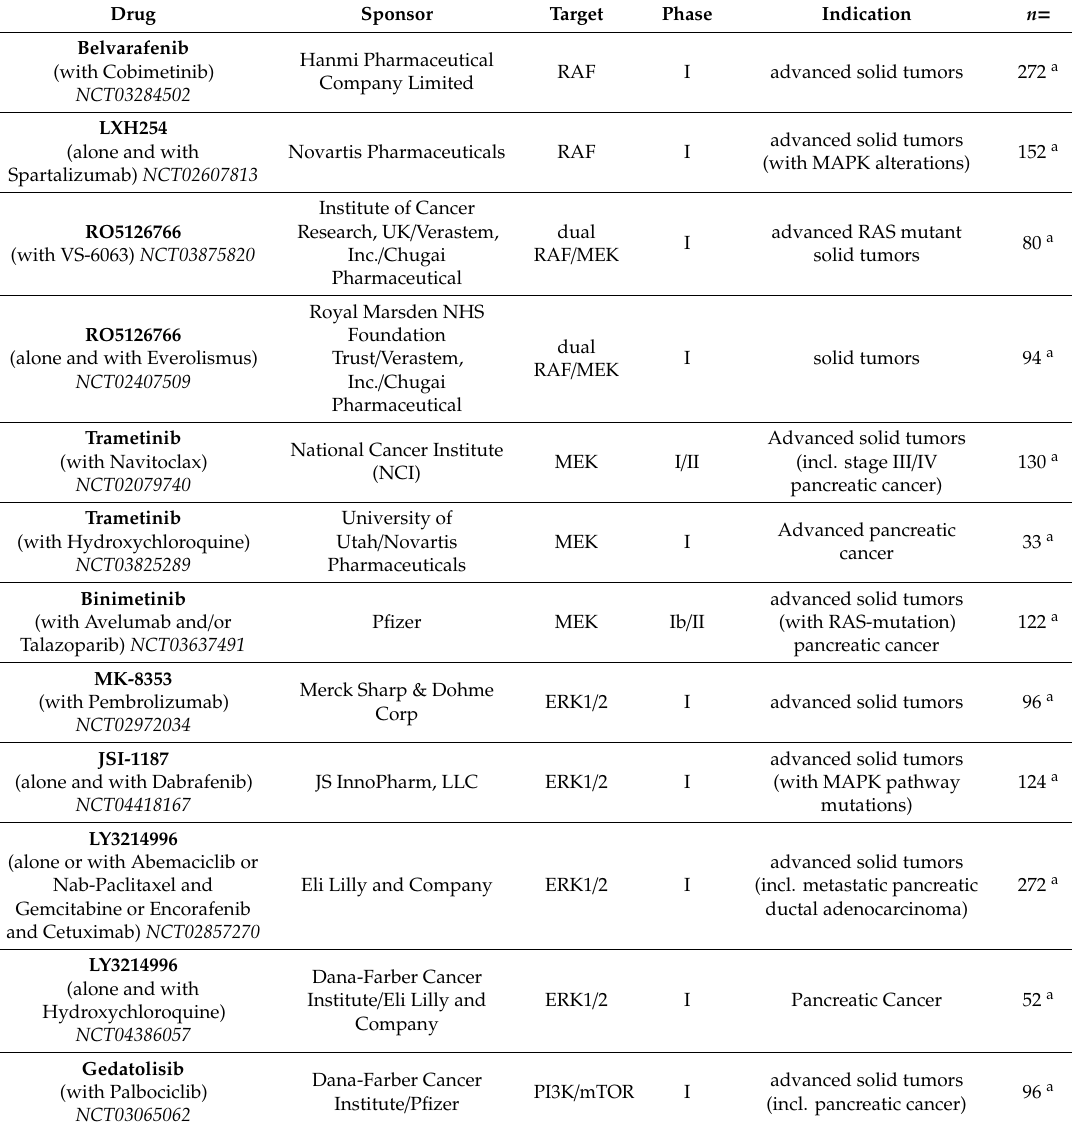
Table 3. Several compounds targeting the signaling cascade downstream of KRAS have reached clinical trials and were subsequently approved for clinical use. Here, we focus on ongoing major clinical trials that include advanced solid tumors or specifically pancreatic